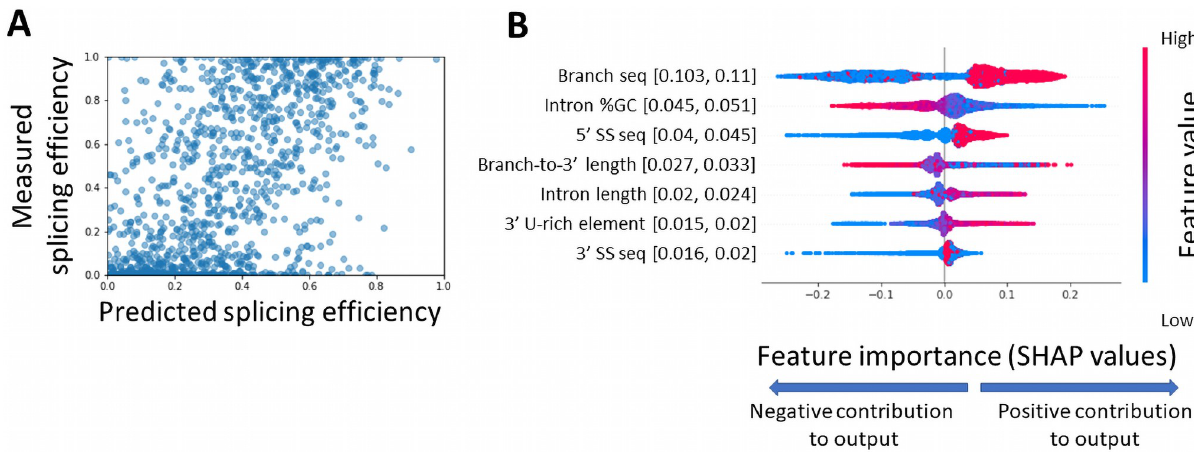
Fig 7. Sequence features contribution to successful splicing are derived from a computational model. A. Measured splicing efficiency values versus predicted splicing efficiency values of the test set variants (N = 3,167) as predicted by a gradient boosting model using 5-fold averaging cross-validation technique (Pearson r = 0.77 p-value < 10 − 100 95% CI = [0.745, 0.774]). B. Distribution of Shapley values for the top 7 features when ranked according to the mean absolute value of the Shapley values. The x-axis represents the Shapley values, the higher the absolute value of the mean of the distribution, the higher its contribution to the model predictions. Positive values mean that the feature is predicted to improve splicing efficiency, and negative values mean that the feature is predicted to reduce splicing efficiency. Sample points are colored according to their feature’s value for numerical features, and for splice site sequences that are treated as categorical features, they are colored by the splice site relative abundance in the S . cerevisiae genome (high values represent abundant sequence variants). Numbers in parentheses represent the 95% confidence interval of the mean absolute value of each feature. We notice that except for the bottom two features, the confidence intervals of features do not overlap, indicating stable ranking of the feature contributions. Confidence interval values were calculated by resampling training and test sets 1000